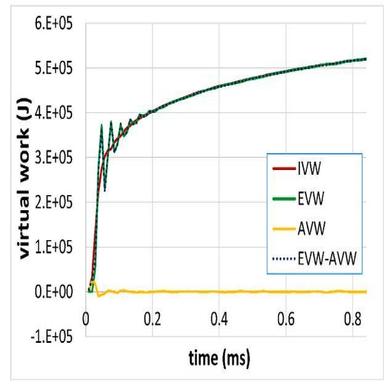
The virtual work balancing result after convergence (FE simulation).